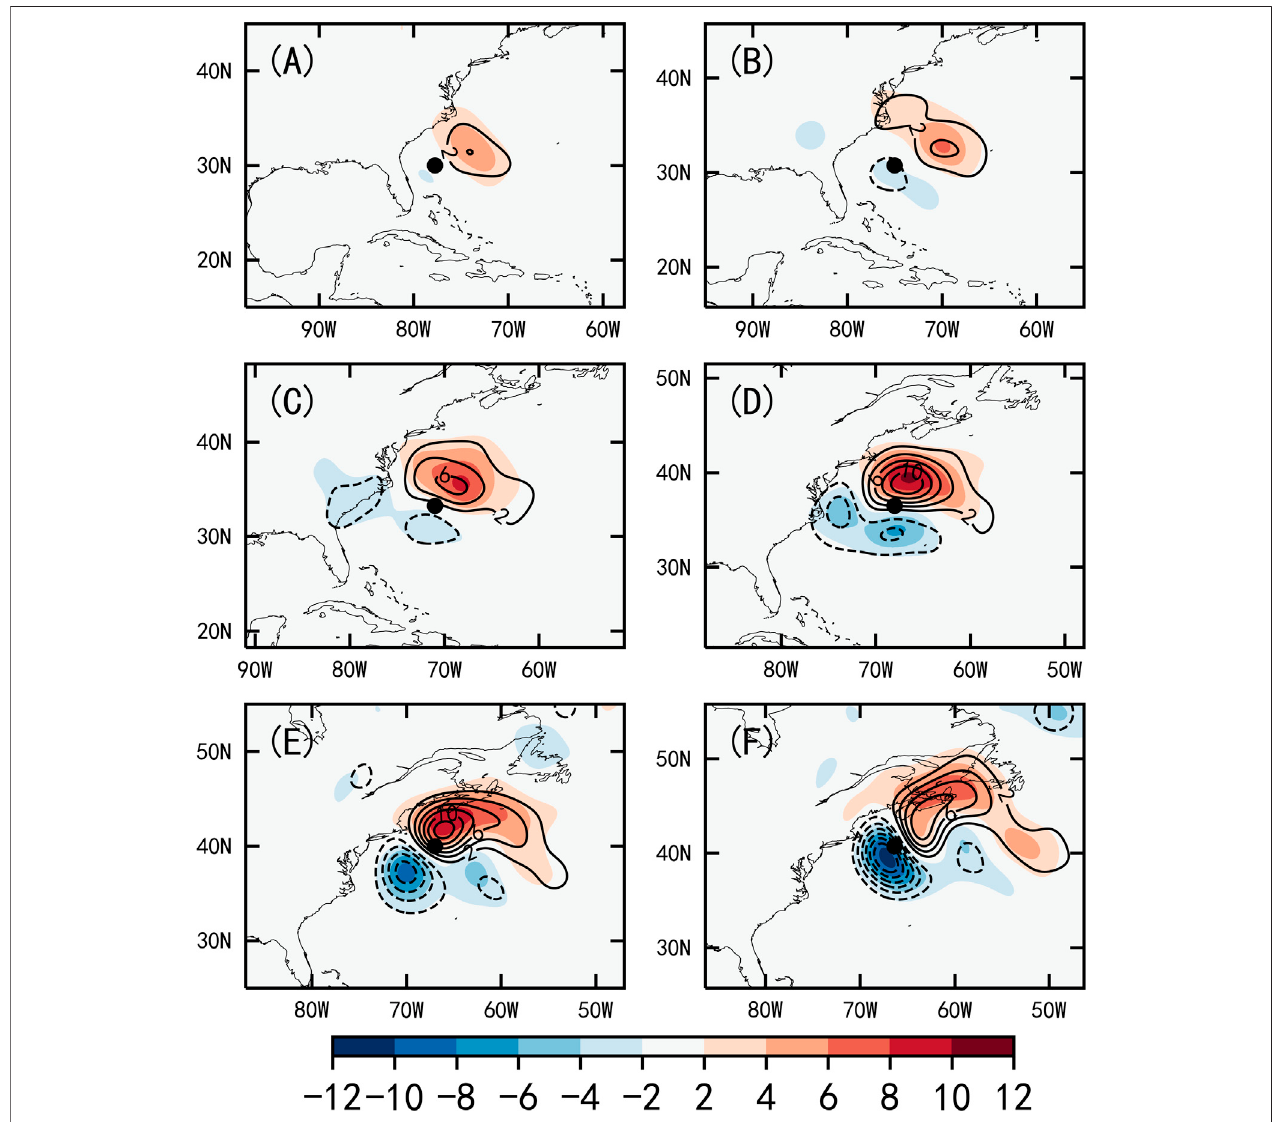
FIGURE 4 | The 950-hPa geostrophic vorticity tendency (the term on the left side of Eq. 2 (LHS), contour interval is 2 × 10 − 9 s − 2 ) and the total tendency (shaded, thesumoffourtermsonthe right sideof Equation2 ,theintervalis2 × 10 − 9 s − 2 )oftheSECat (A) 12UTC25, (B) 18UTC25, (C) 00UTC26, (D) 06UTC26, (E) 12UTC 26, and (F) 18 UTC March 26, 2014. The large solid dot denotes the SEC center.